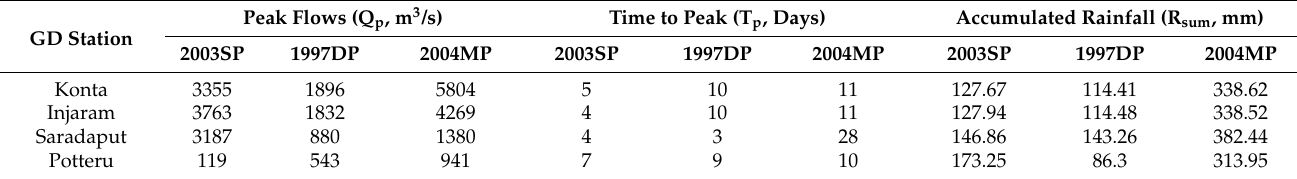
Table 2. Similar to Table 1, but for three interior locations of the Sabari River Basin (SRB) along with the outlet, Konta. GD